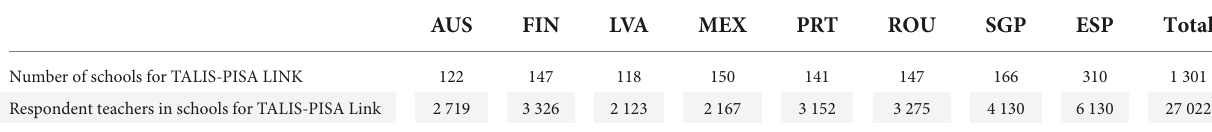
TABLE 2 Overview of the original raw data of TALIS-PISA Link 2013 samples.